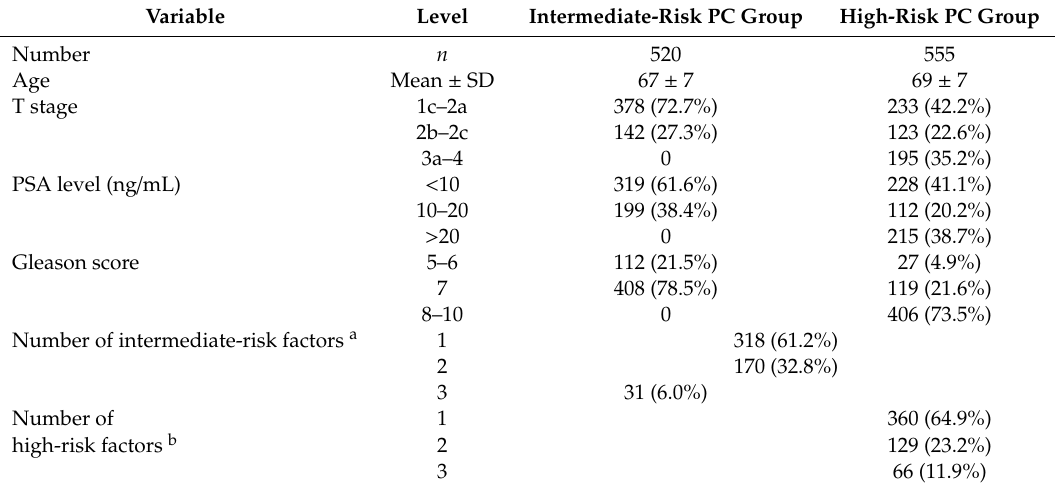
Table 1. Patient characteristics according to the National Comprehensive Cancer Network risk classification.